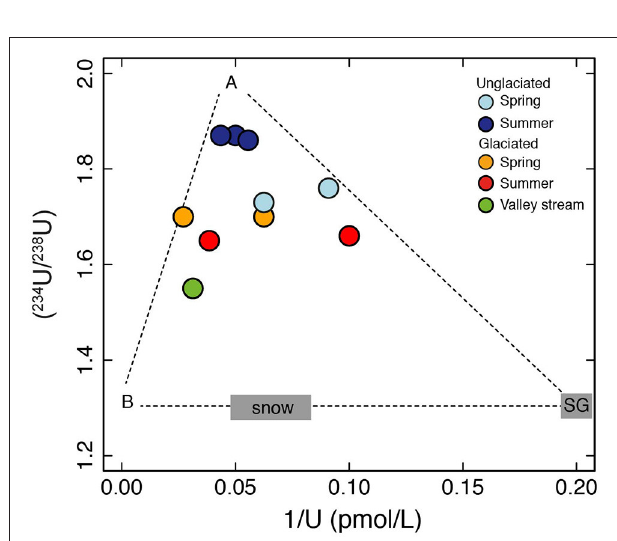
FIGURE 4 | A plot of ( 234 U/ 238 U) vs. 1/U. U concentrations and activity ratios can be explained by mixing between at least three end-members. One end-member (A) has relatively high U concentrations and high activity ratios and is inferred to derive from water with a long residence time. The other two end-members represent short water residence time sources. One is consistent with ice melt with low uranium concentrations represented by the supraglacial sample (SG) and the other (B) has high uranium concentrations and may derive from a mineral source such as carbonate. U from snow or dust contained within snow is an additional end-member and could be important for the spring samples which were collected during snow-melt. We do not have direct measurements of the latter three end-members and plot them using the U activity ratio of 1.3 measured in Siberian snow (Bagard et al., 2011). The lower activity ratio of snow compared to the stream water samples is consistent with short water residence times expected for snow and ice melt (Koch et al.,